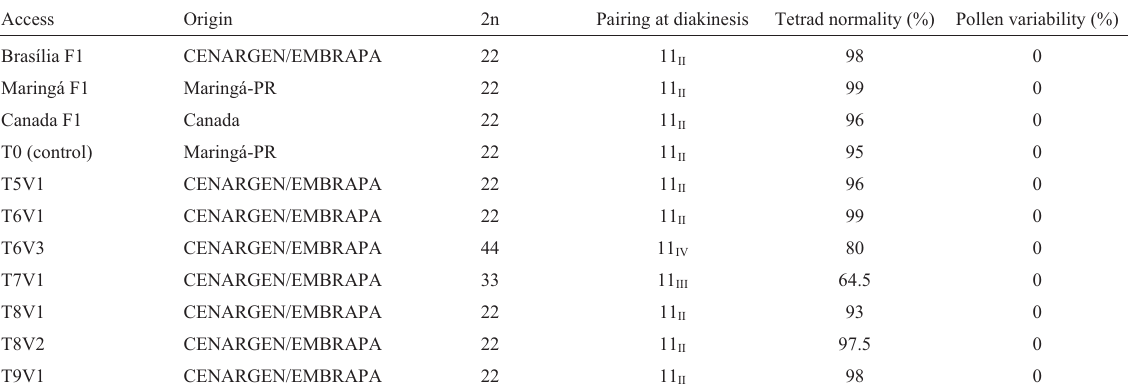
Table 1 - Chromosome number (2n), pairing at diakinesis, tetrad normality and pollen viability (%) in strains of Stevia rebaudiana (Bertoni) Bertoni.